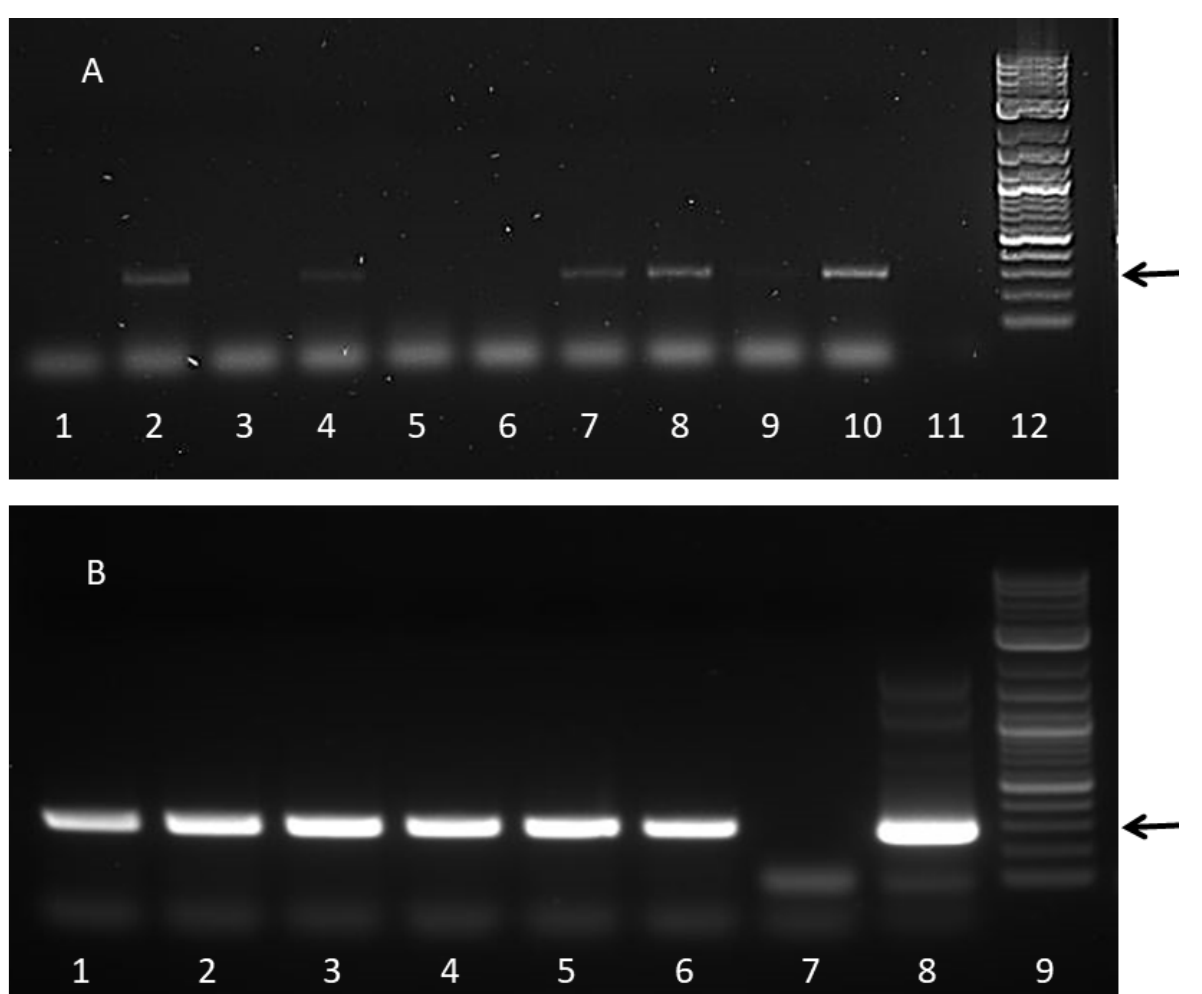
Figure 4. An omp2a test analysis of field serum samples confirmed positive by CFT serology, obtained from two infected sheep farms, ( A , B ). ( A )—Experiment 1 (Figure 4A)—Serum samples number 2, 4, 7 and 8 out of nine as well as a control sample (lane 10) depict the correct 282 bp DNA band (black arrow). Lane 11 depicts a negative control sample. ( B ) Experiment 2 (Figure 4B)—six out of six serum samples as well as a control sample (lane 8) depict the correct 282 bp DNA band (black arrow). Lane 7 depicts a negative control sample.